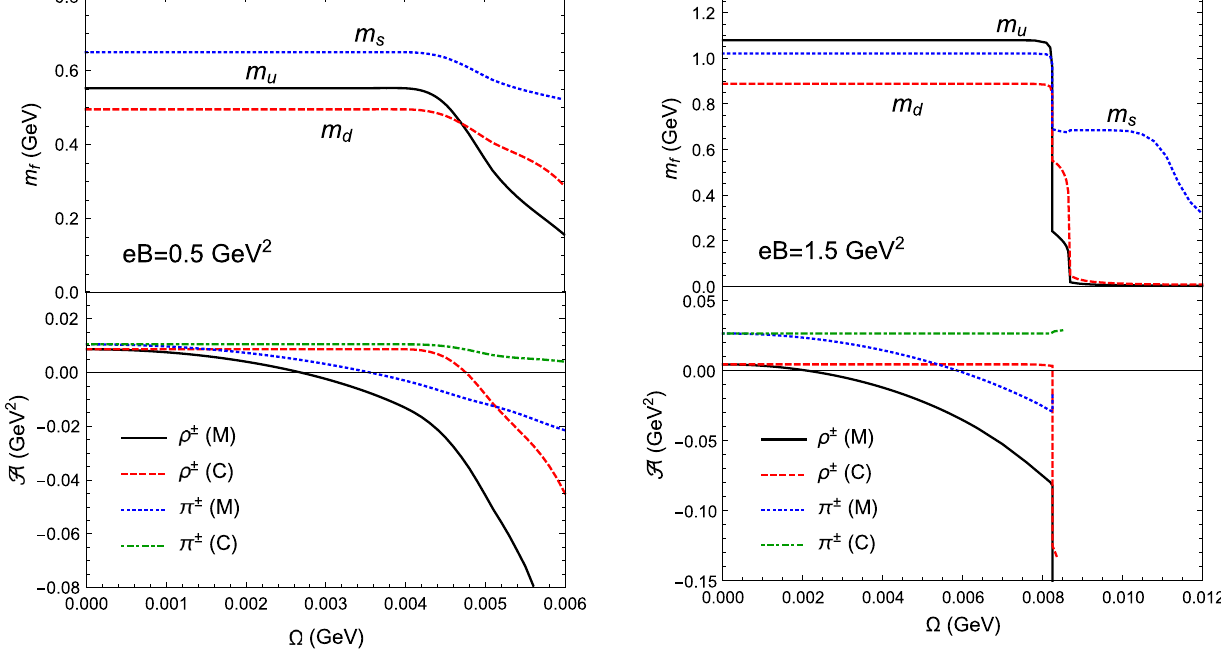
Fig. 3 The evolutions of the dynamical quark masses m f (upper panel) and the quadratic GL expansion coefficients A (lower panel) with the angular velocity (cid:5) at the magnetic field eB = 0 . 5 GeV 2 . In the lower panel, the coefficients of charged rho condensation are compared to those of charged pion for both choices of SP in Minkowski space and SP in curved space, denoted by “M” and “C”, respectively